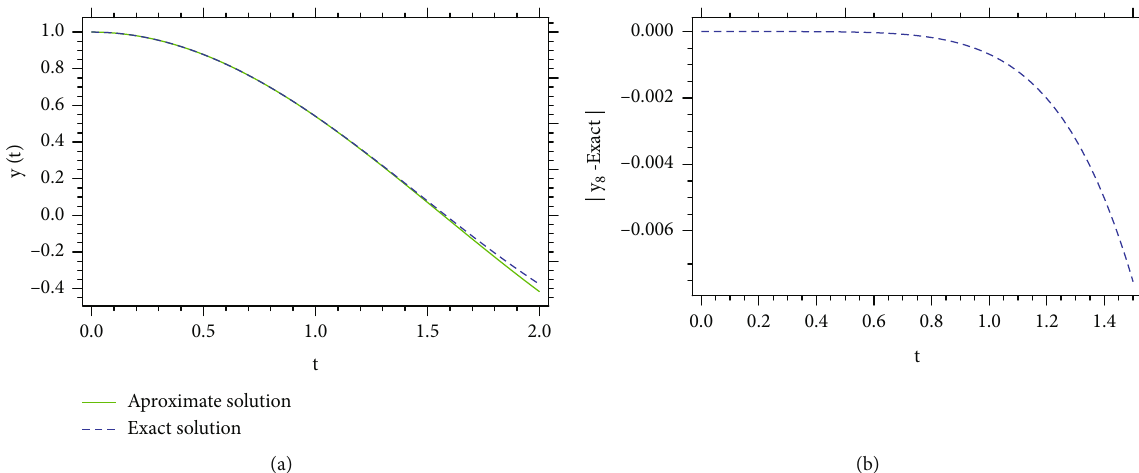
Figure 5: (a) 2D solution plots of Example 5 obtained by the present method in comparison with the exact solutions : (b) The absolute errors of Example 4. Table 3: Eight-term approximate solution by SIM and comparison with the exact solution of Example 1 for di ff erent values of time variable t and the absolute error E = j y 8 − exact j .